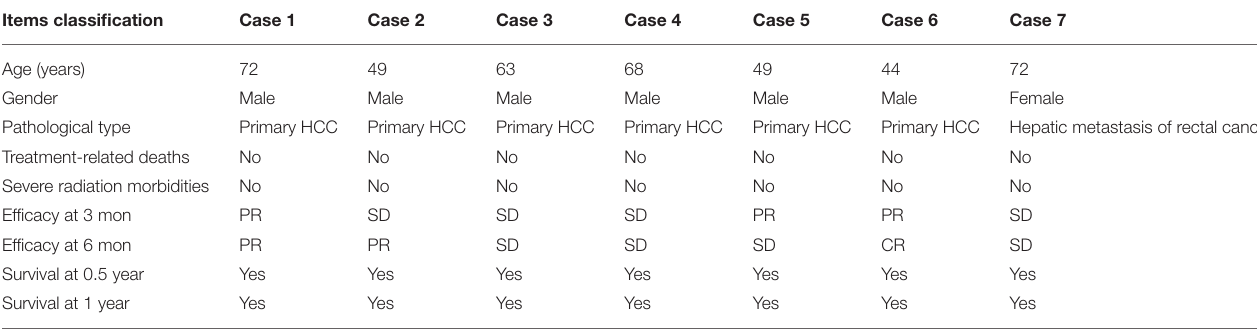
TABLE 3 | Clinical outcomes of CIRT with the first Chinese carbon ion therapy system (CITS) for patients with liver cancer. Items classification